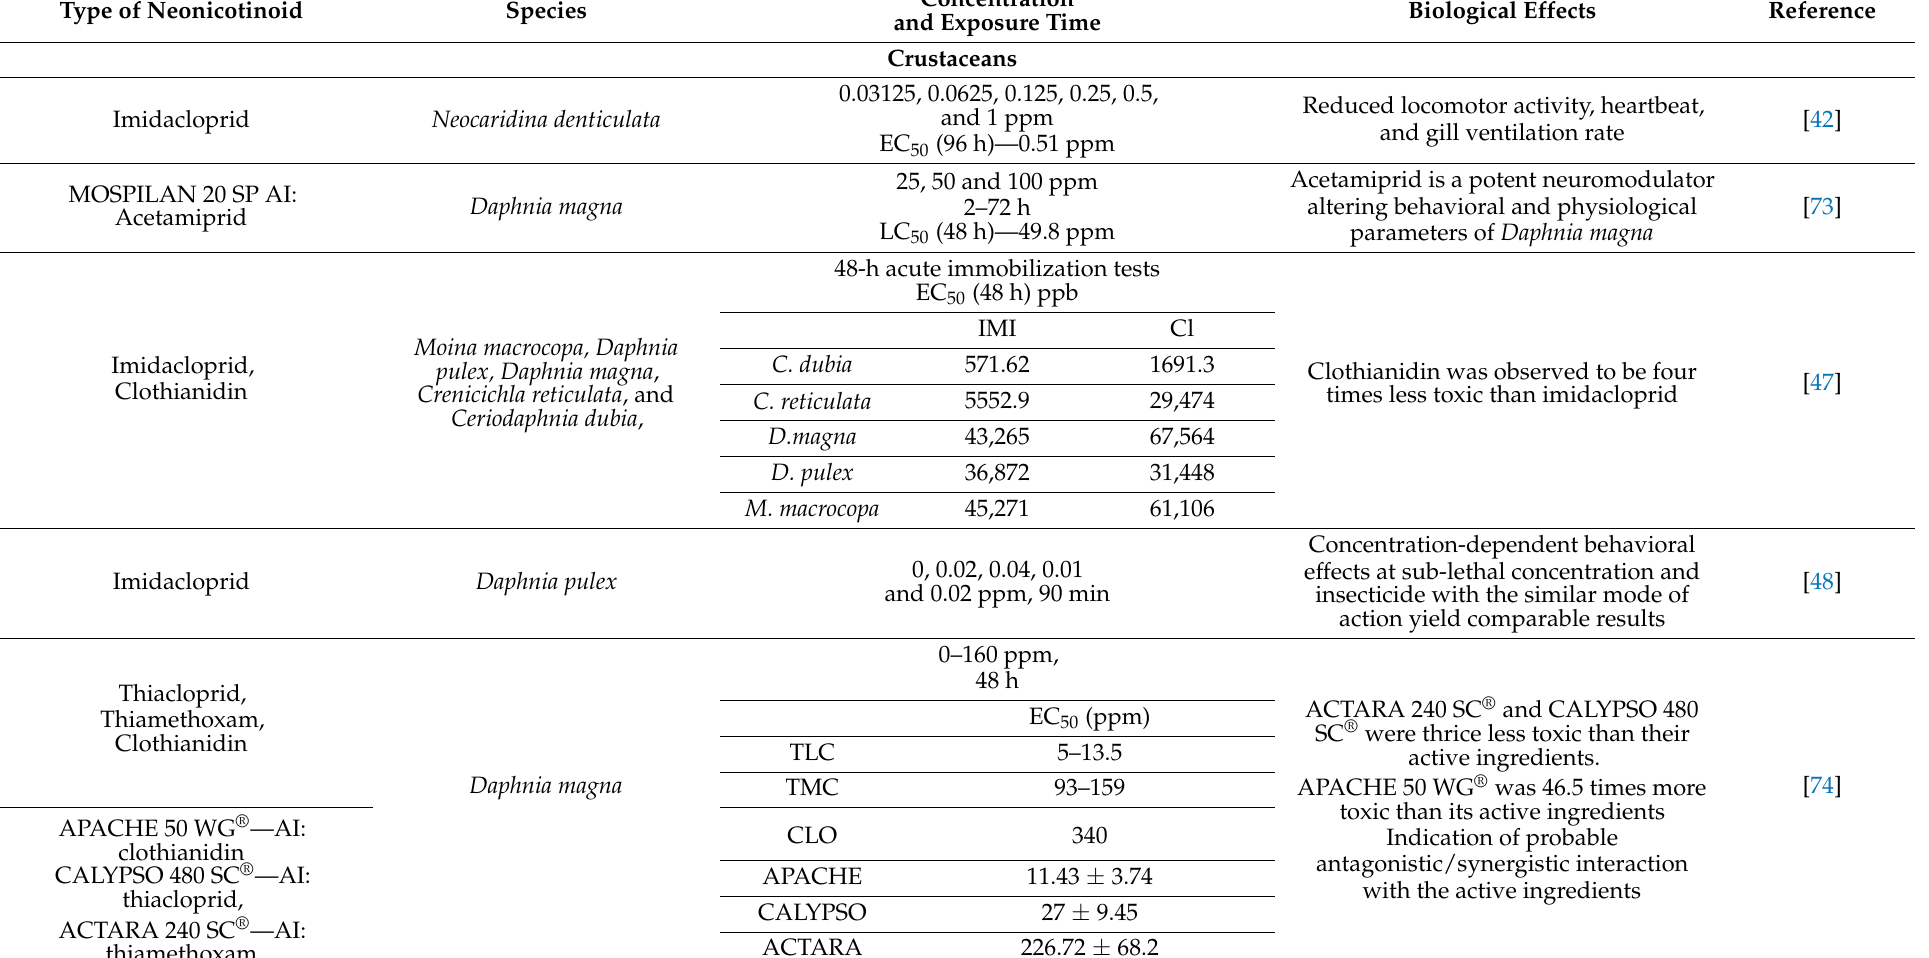
Table 1. The potential adverse effects of neonicotinoid insecticides on aquatic